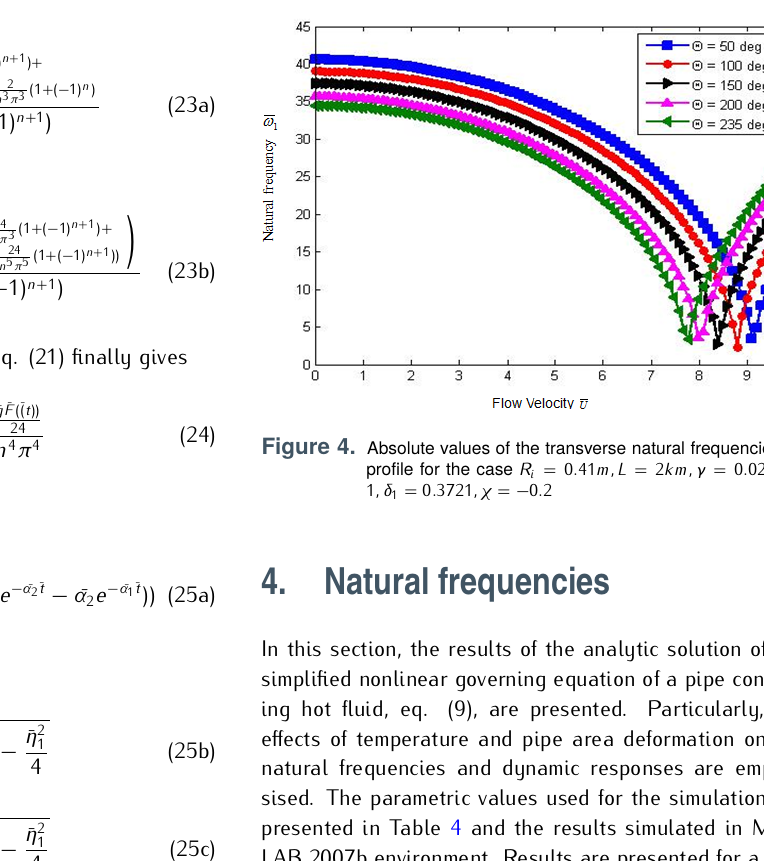
Figure 3. Absolute values of the transverse natural frequencies profile for the case R i = 0 . 41 m,L = 2 km,γ = 0 . 02 ,δ 0 . 3721 , Θ = 100 ◦ C,χ = − 0 . 2